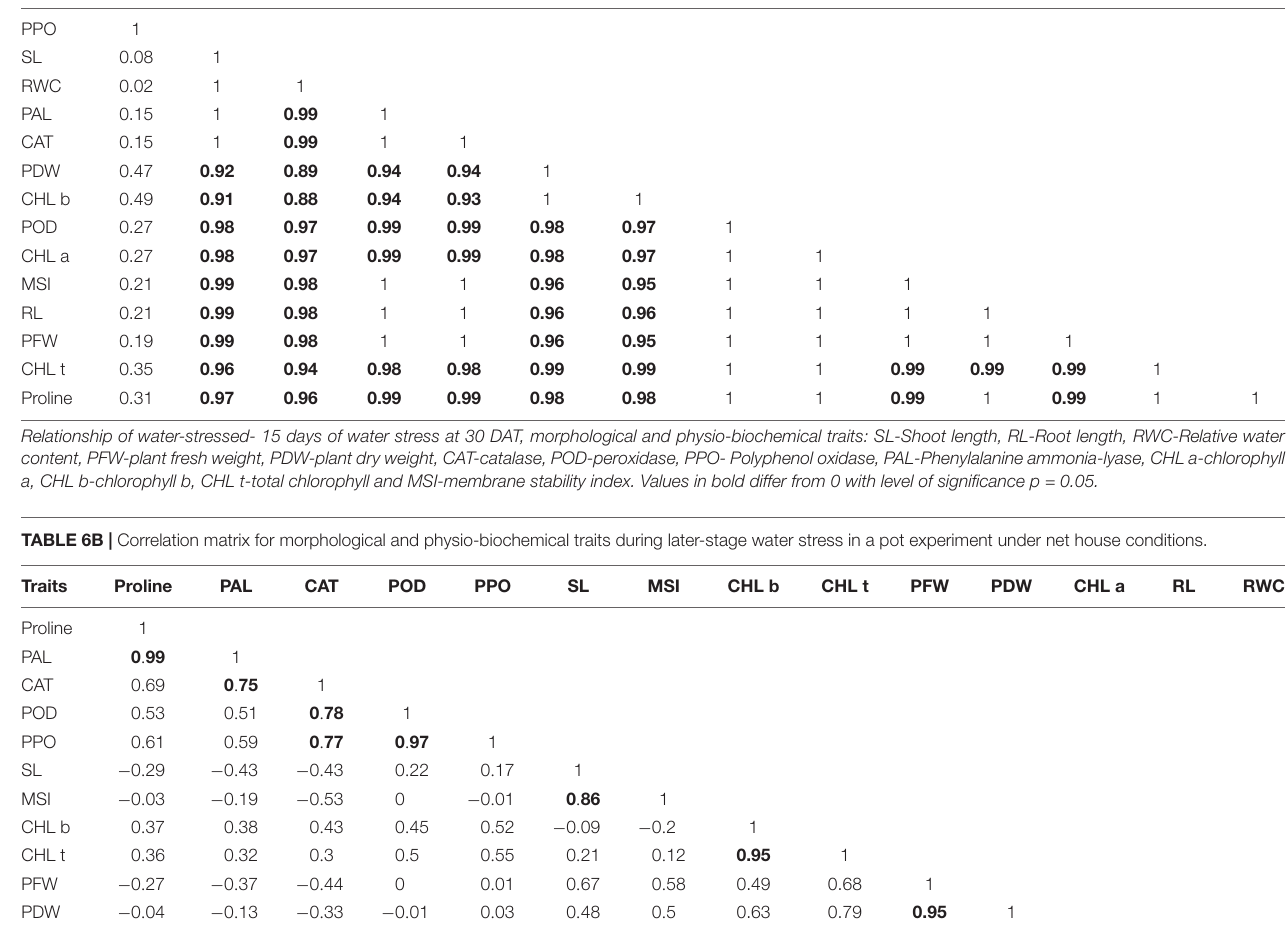
TABLE 6A | Correlation matrix for morphological and physio-biochemical traits during early-stage water stress in a pot experiment under net house conditions. Traits PPO SL RWC PAL CAT PDW CHL b POD CHL a MSI RL PFW CHL t Proline PPO 1 SL PAL 0.15 0.99